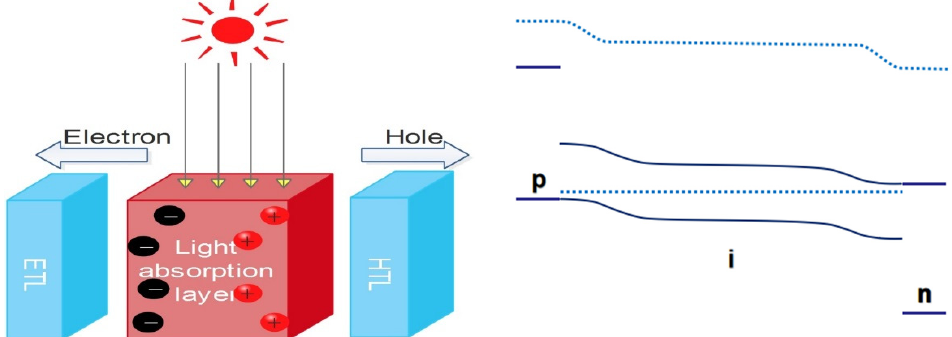
Figure 2. A schematic diagram of a plane perovskite solar cell.